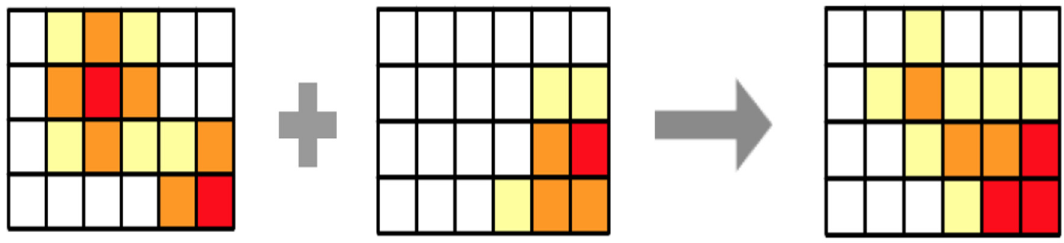
Figure 2. Example of geographical combination of belief maps from different hypotheses.